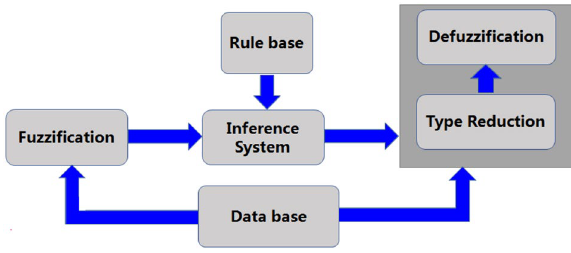
Fig. 4 Interval type-2 FLS